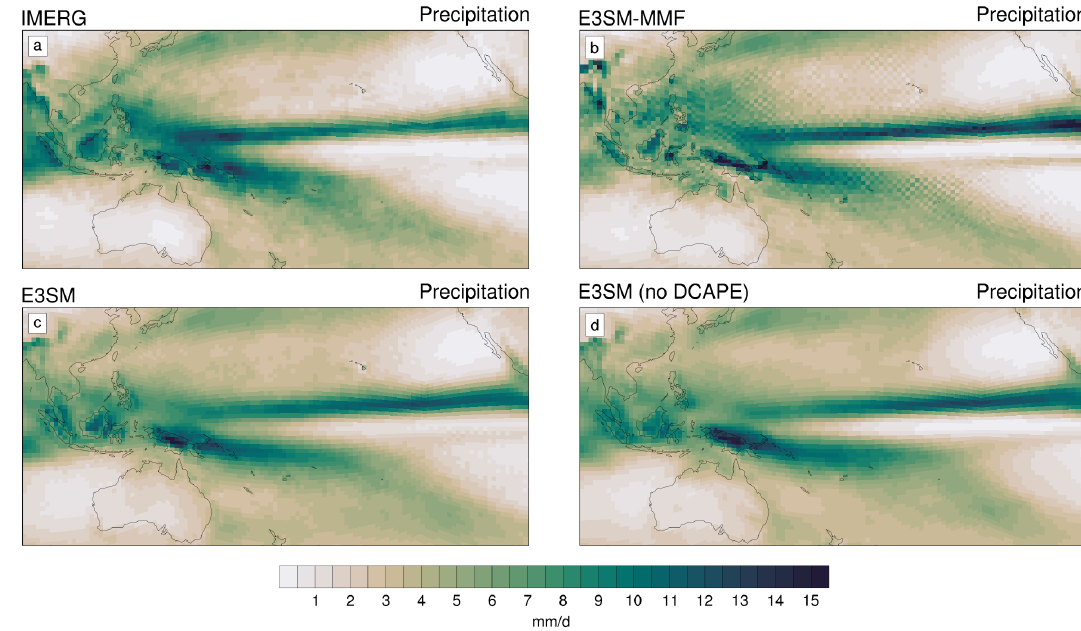
Figure 5. Maps of 5-year mean precipitation for IMERG, E3SM-MMF, E3SMv2, and E3SMv2 with the DCAPE trigger disabled.